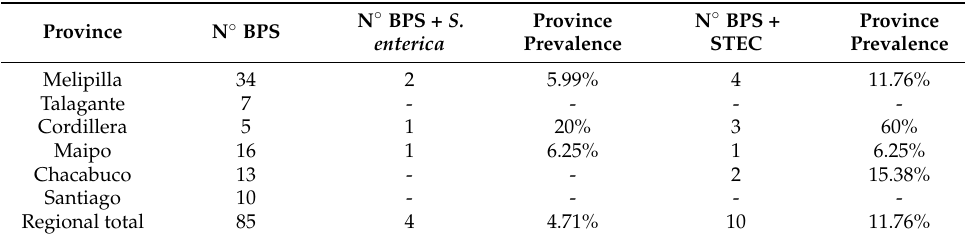
Table 4. Number of positive BPS with respect to STEC and S. enterica by